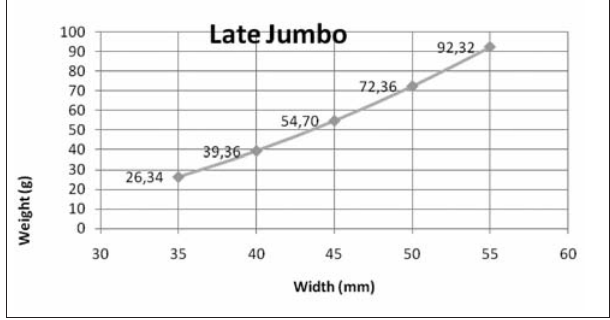
Fig. 35: Weight values calculated from the width-weight relationship